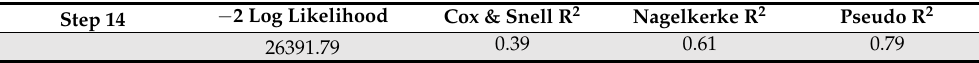
Table 7. Logistic regression model results.